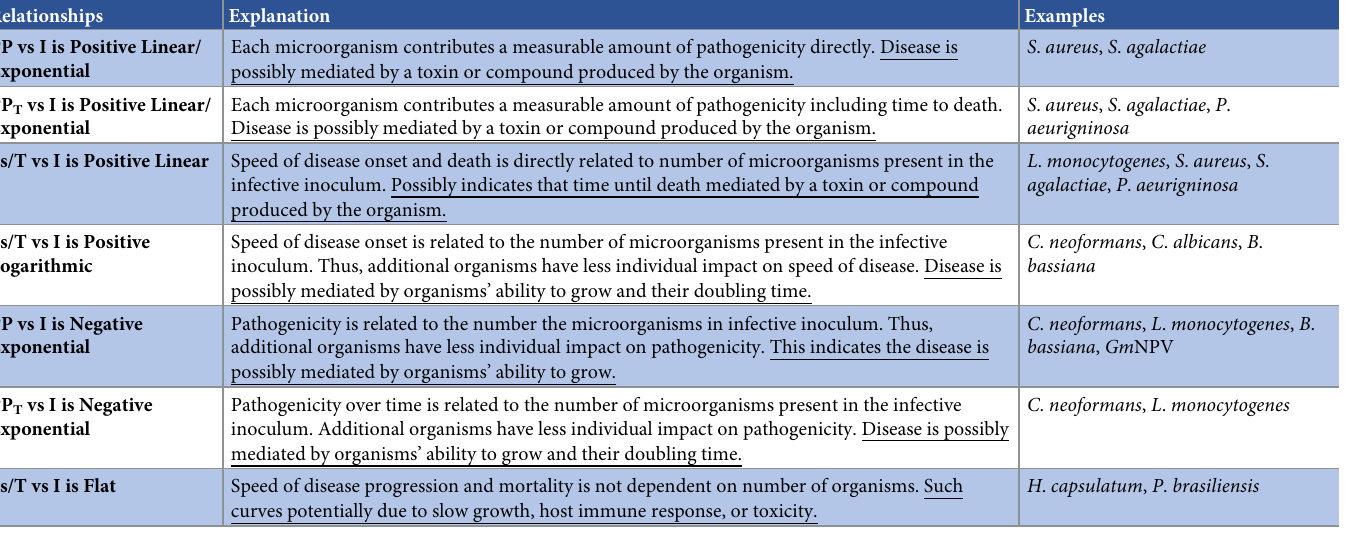
Table 1. Relationships between PP , PP T , and Fs/T with inoculum , proposed explanation , and examples of microbes . Relationships